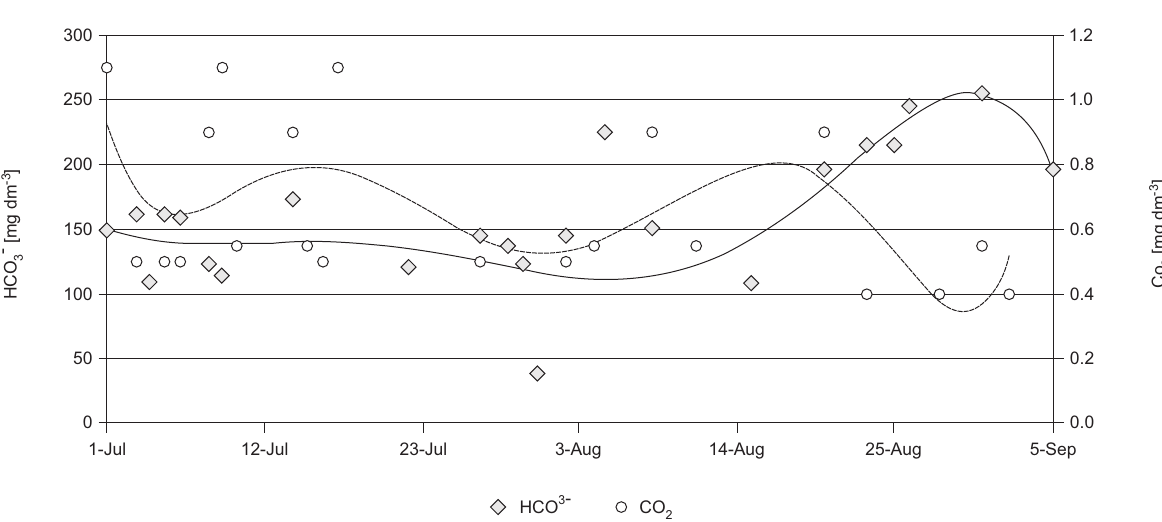
Fig. 11. Concentration of HCO